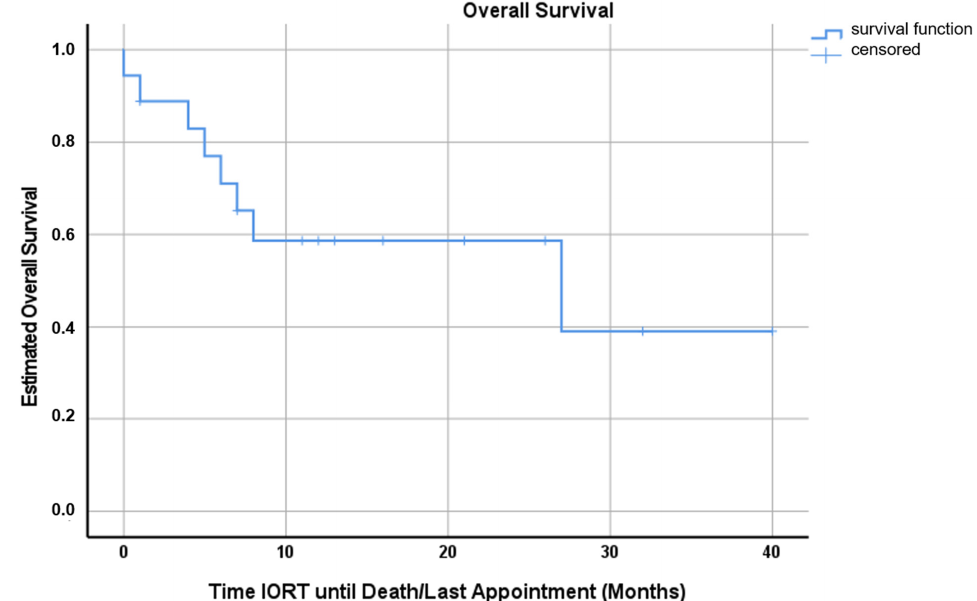
There was one case with the recurrence of suspected local metastases (patient no 8) Figure 1. Kaplan–Meyer curve for overall survival with a mean OS of 22.8 months (range, 0–39